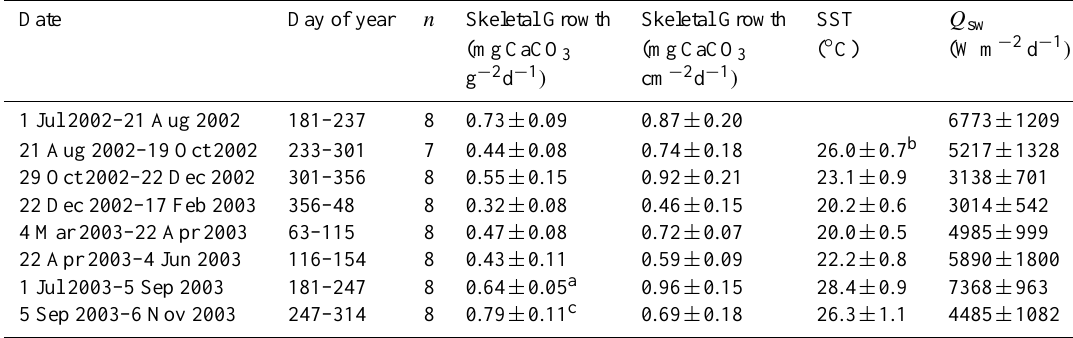
Table 2. In situ rates of skeletal growth of Diploria labyrinthiformis from Hog Reef on the rim reef of Bermuda.